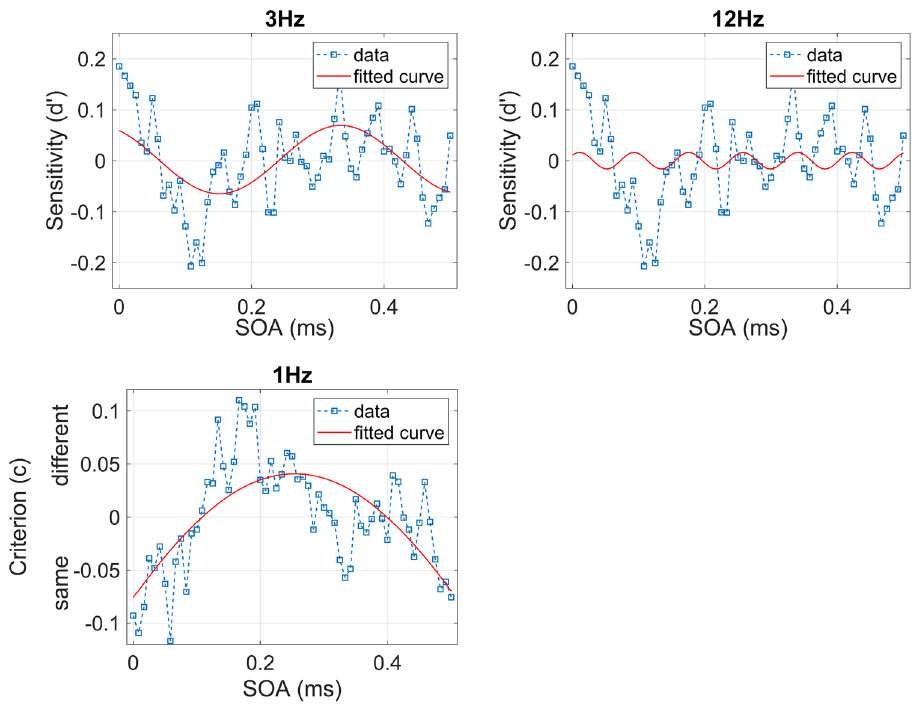
Figure 5. The upper panel shows the 3 Hz (upper left panel) and 12 Hz (upper right panel) sinusoidal fit for d’. The lower panel shows the 1 Hz sinusoidal fit for